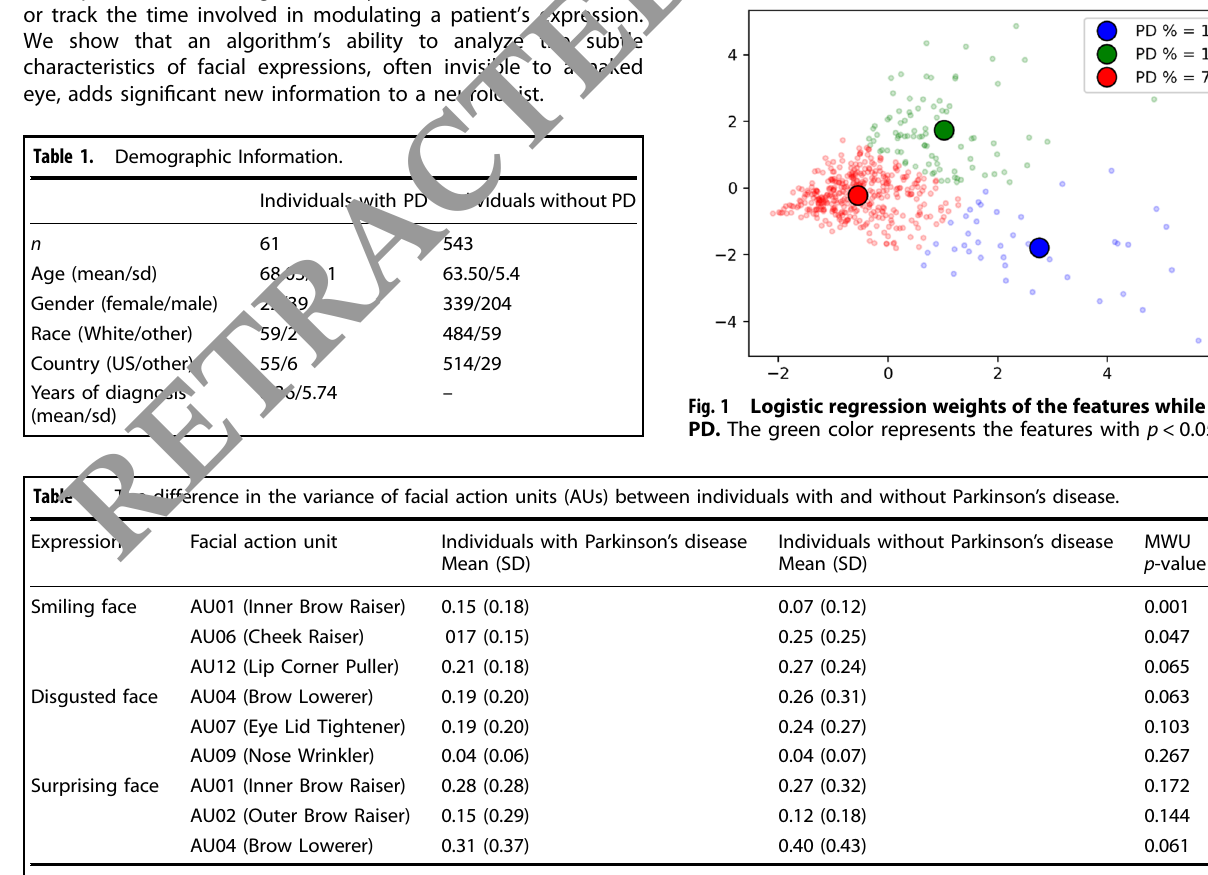
Table 1. Demographic Information.